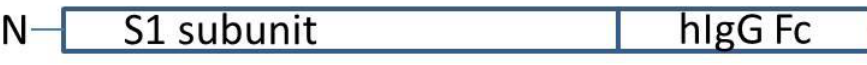
Figure 1. Schematic drawing of the soluble spike proteins. S1 subunits are fused c- terminally to the human IgG Fc